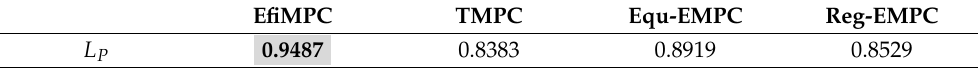
Table 1. The closed-loop operation performance of the comparative control